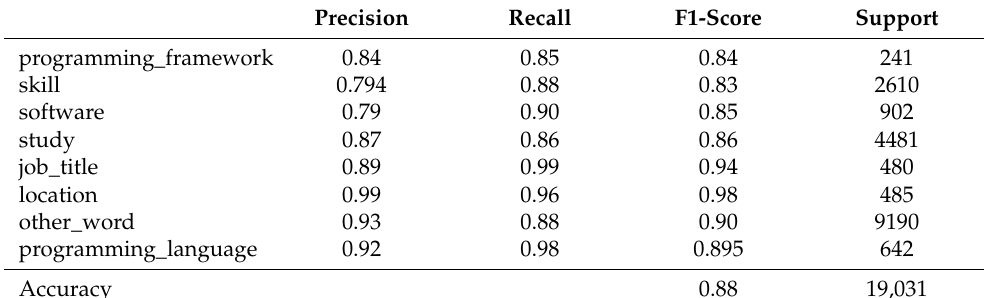
Table 3. Precision, Recall, and F1 scores of the customized NER, with regard to the predefined classes.